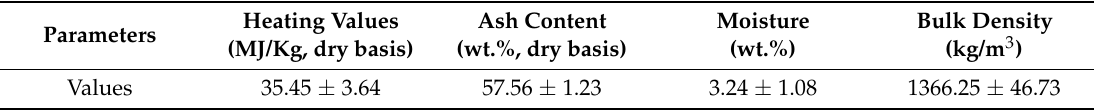
Table 2. Features of upstream oily